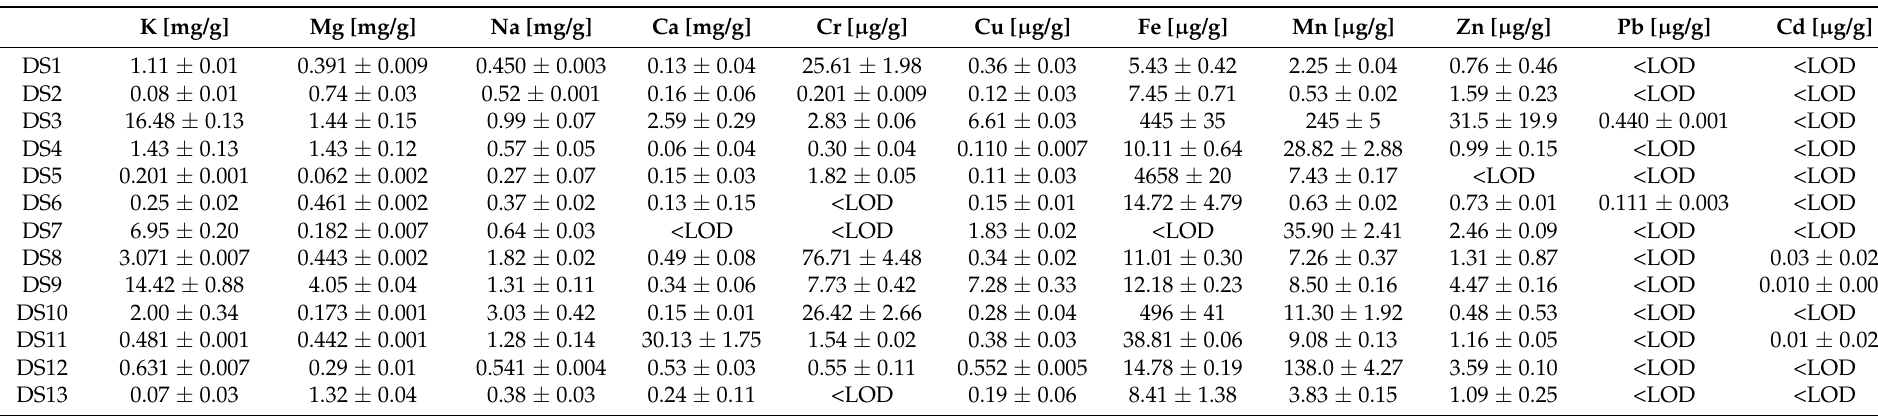
Table 4. Content of the selected elements in the analysed dietary supplements [mg/g and µ